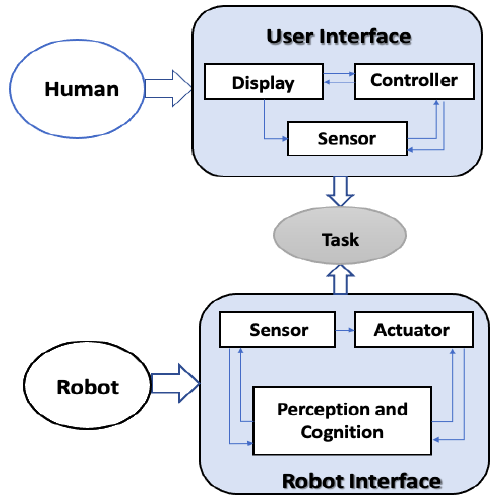
Figure 3. Block diagram of collaborative control